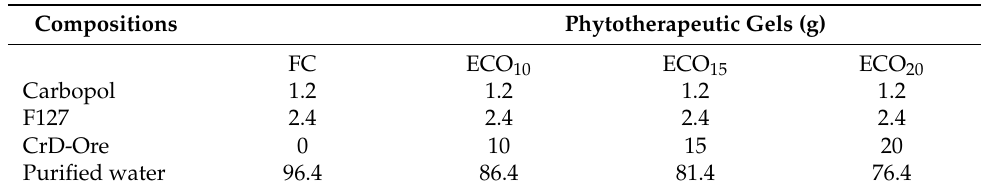
Table 1. Composition for 100 g of